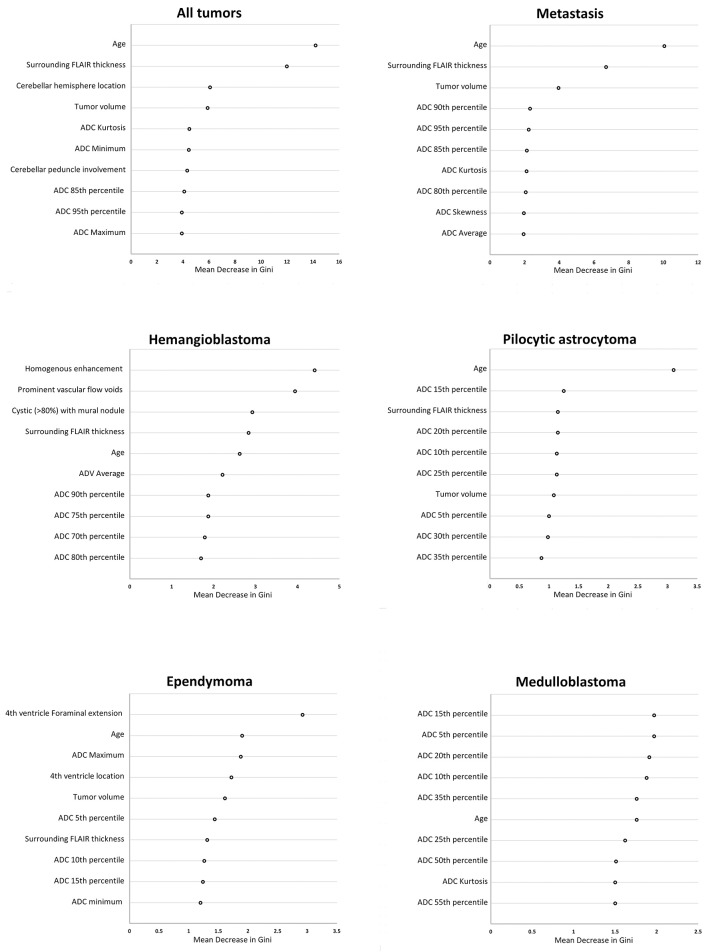
The “mean decrease in Gini coefficient” in random forest models for differentiation of posterior cranial fossa tumors. Separate random forests models were developed for differentiation of all posterior fossa tumors from each other in multiclass analysis, as well as dichotomized classification for the 5 most common posterior fossa neoplasms. The top 10 variables with the highest averaged “mean decrease in Gini coefficient” among from ×100 repeats of 5-fold cross validation are reported. ADC, apparent diffusion coefficient; FLAIR, fluid attenuated inversion recovery.